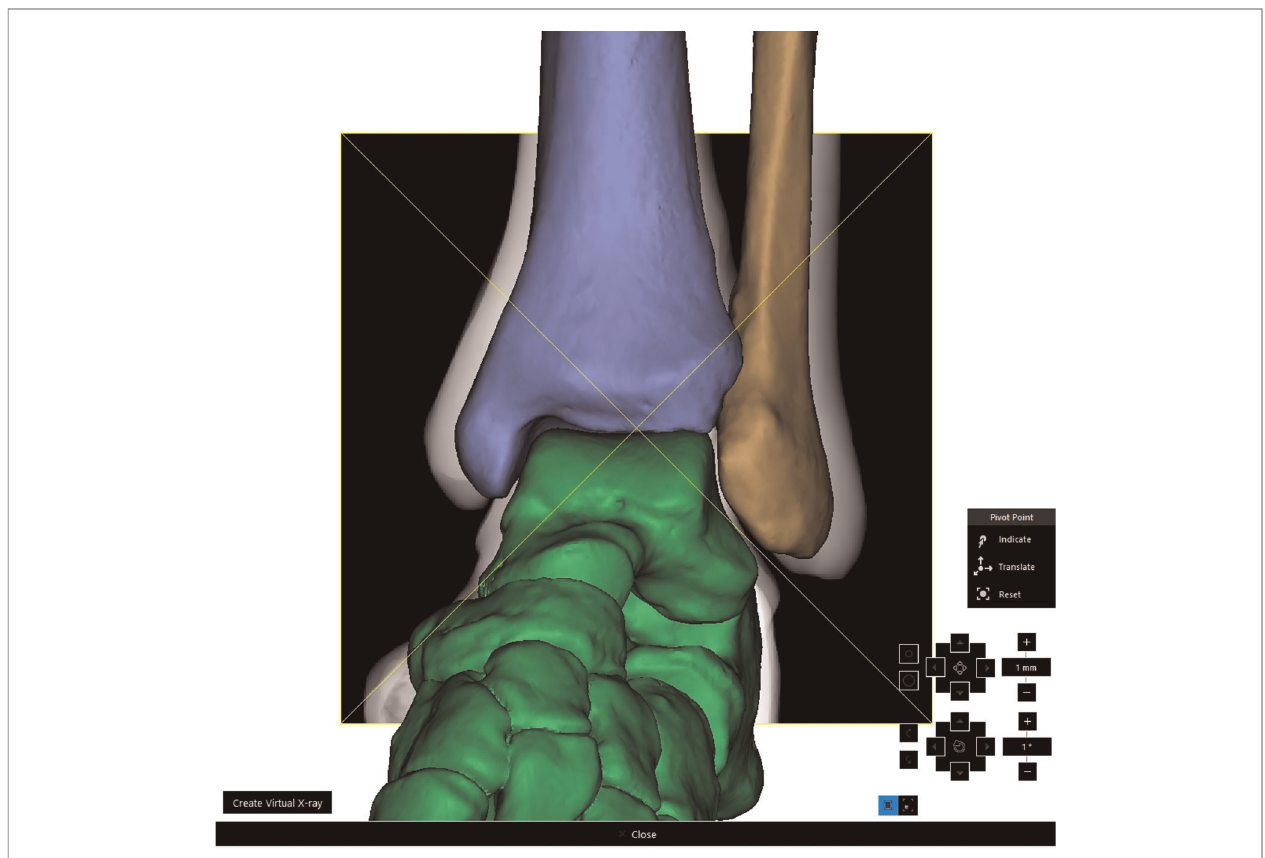
FIGURE 4 | Simulation of intraoperative fl uoroscopy with “ virtual X-ray ” function in